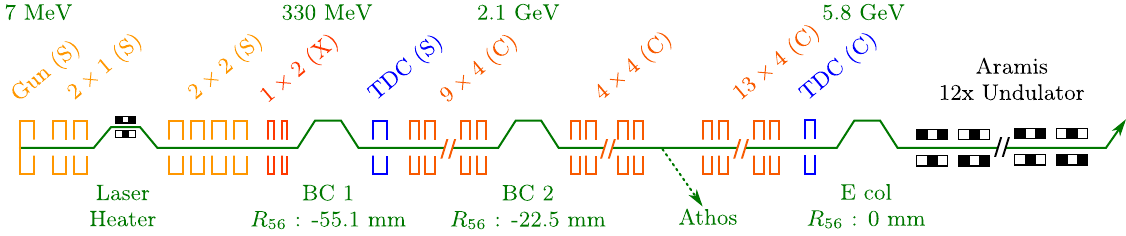
FIG. 1. Schematic drawing of SwissFEL. The R 56 of the energy collimator is deliberately set to zero for most operation modes. For the RF stations (frequency band given in bracket) the first number denotes the number of modulators, the second the number of connected cavities to each modulator.